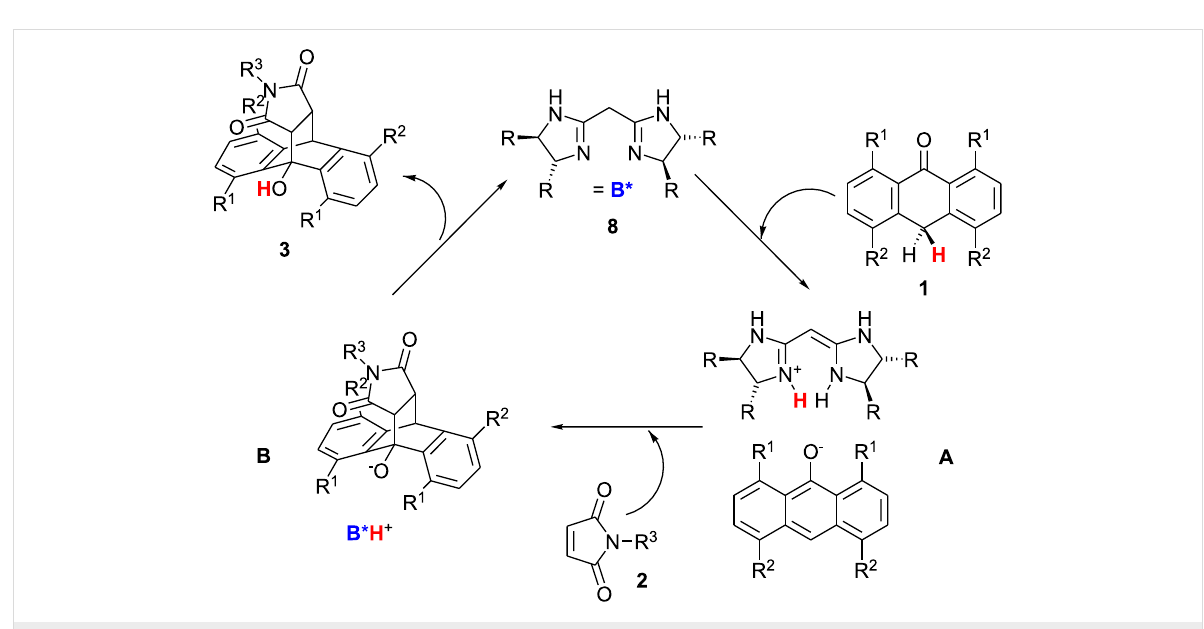
Scheme 4: Proposed mechanism of the Diels-Alder reaction.